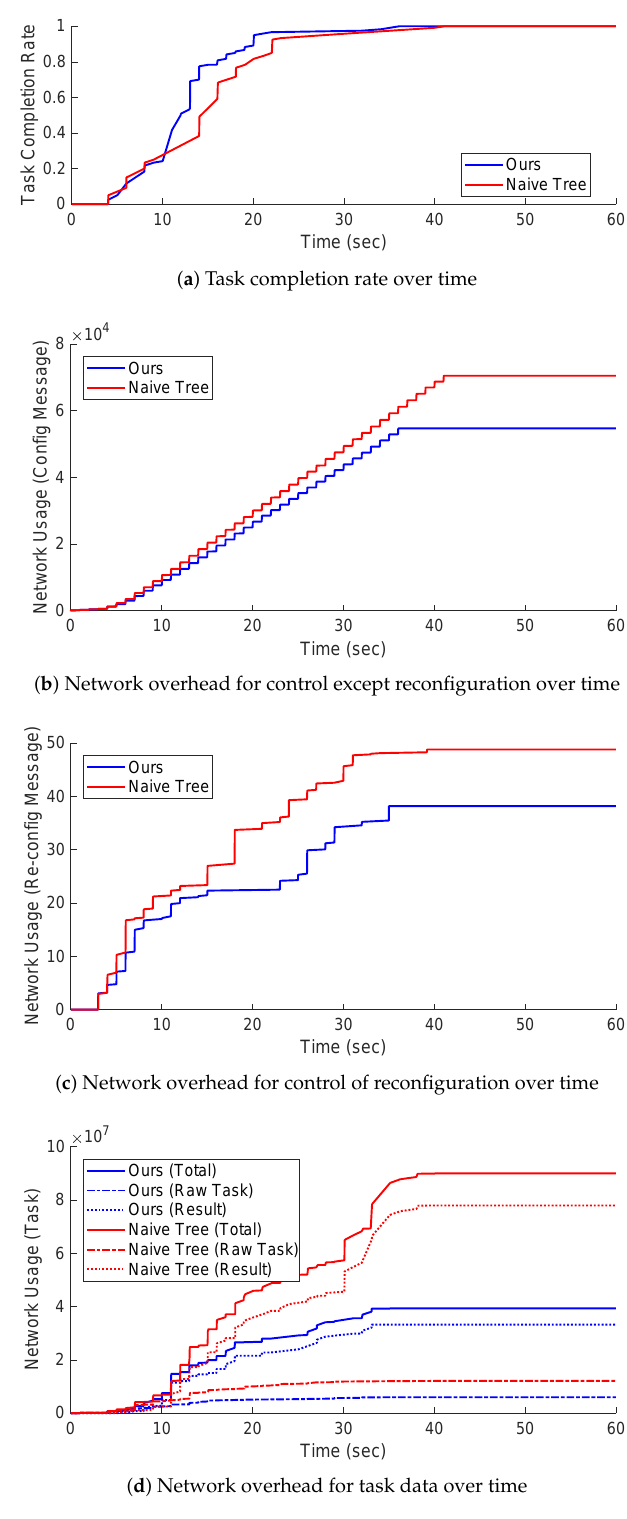
Figure 17. Dynamic computation performance for our algorithm and a naive tree-based algorithm over time until the deadline where the number of tasks is 120 in Topology